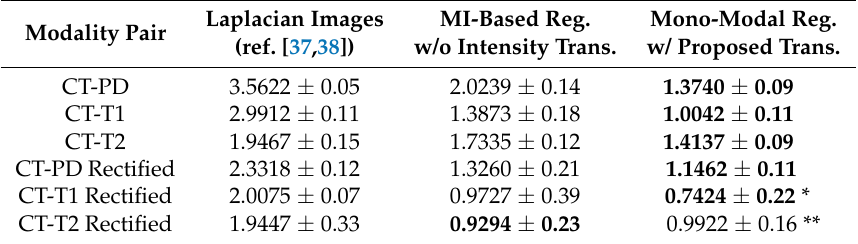
Table 2. Mean and standard deviation of distance error (in millimeter) for each pair of CT-MR modality scans. Images are aligned using Laplacian images [37,38], MI-based registration, and the proposed transformation followed by mono-modal